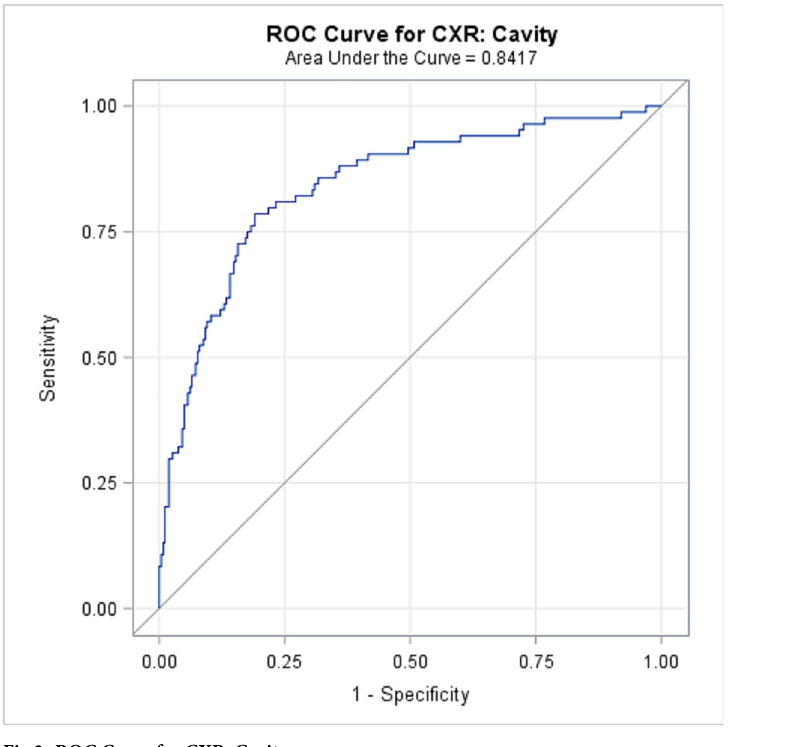
Fig 2. ROC Curve for CXR: Cavity.